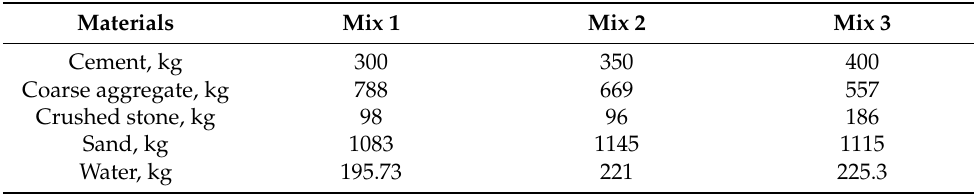
Table 3. Concrete mix design.